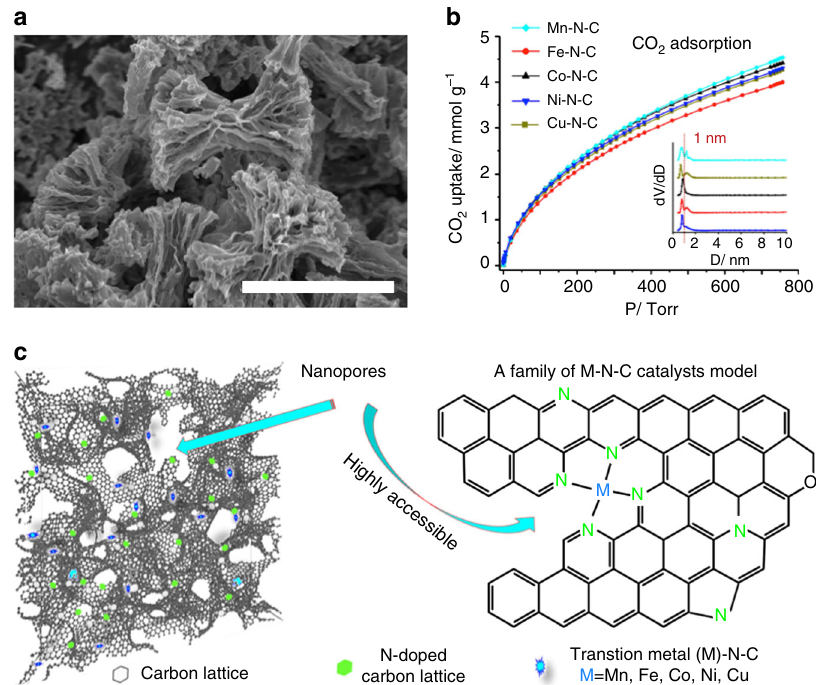
Fig. 1 Visualization, porosity and illustration of the M – N – C catalyst. a Typical SEM image of the family of N-coordinated metal-doped (M – N – C) carbon electro-catalysts, scale bar = 4 μ m; b CO 2 physisorption isotherm (273 K); inset: the pore size distribution; c Materials model and a schematic local